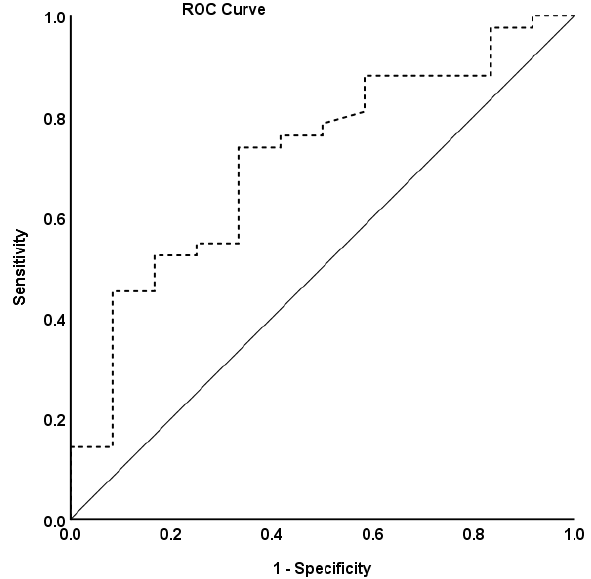
Figure 2. Receiver operator characteristic curves for predicting cardiovascular autonomic neuropathy. AN diagnostic accuracy is shown based on the receiver operating characteristic curve analysis.